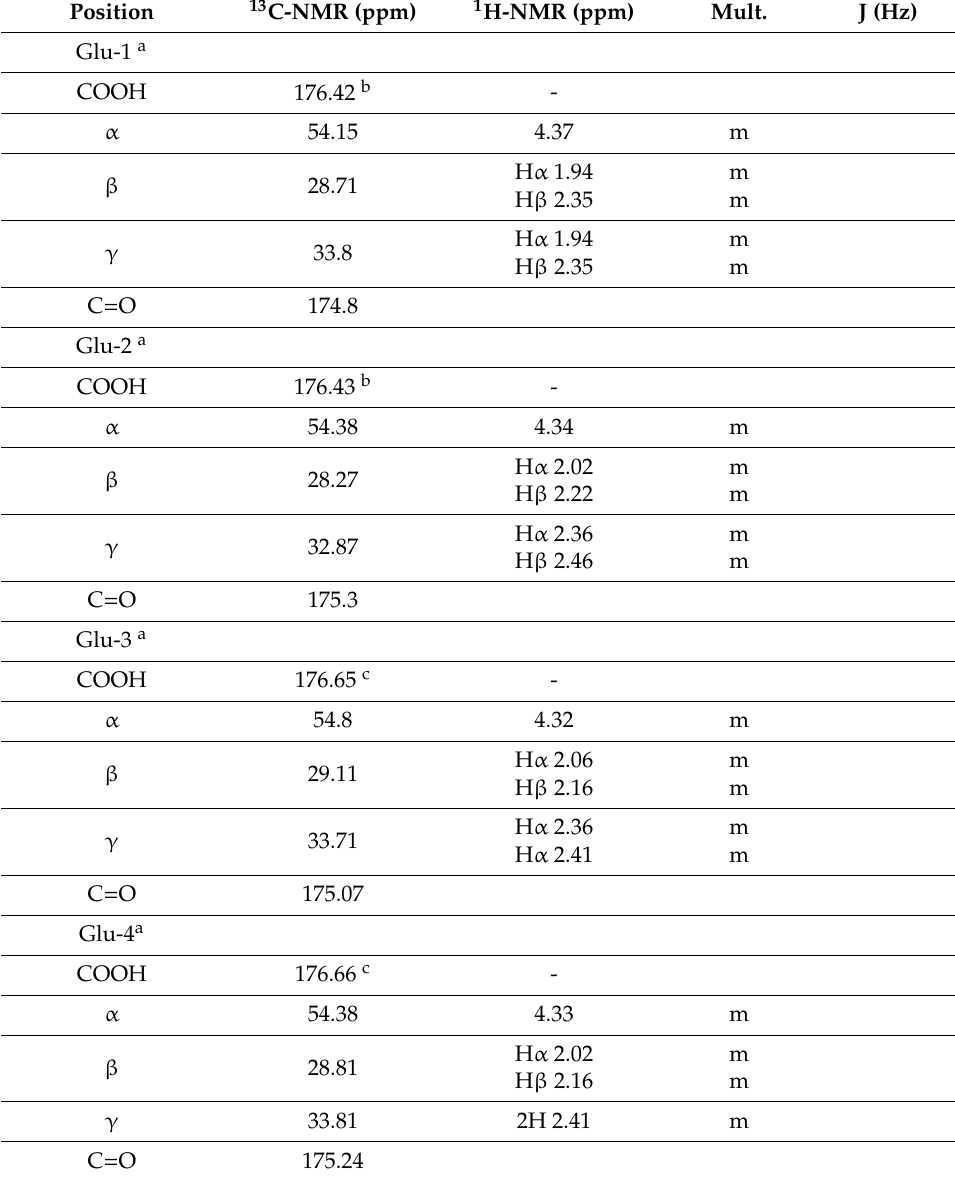
Table 3. 1 H-NMR (800 MHz) and 13 C-NMR (200 MHz) for cnidarin 4B ( 2 ) in CD 3 OD.